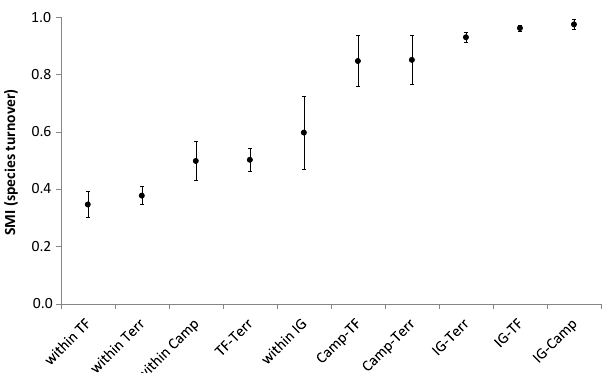
Figure 4. Species turnover of the four inventoried forest types at the ATTO site. Turnover is expressed as Shmida and Wilson’s (1985) index: SMI = (g + l)/(a + b) ; where g and l are gained and lost species from site 1 to site 2; a and b are the numbers of species in site 1 and site 2. TF = terra firme forest upon plateau, Terr = terra firme forest upon fluvial terrace, Camp = campinarana, and IG = seasonally flooded black-water forest